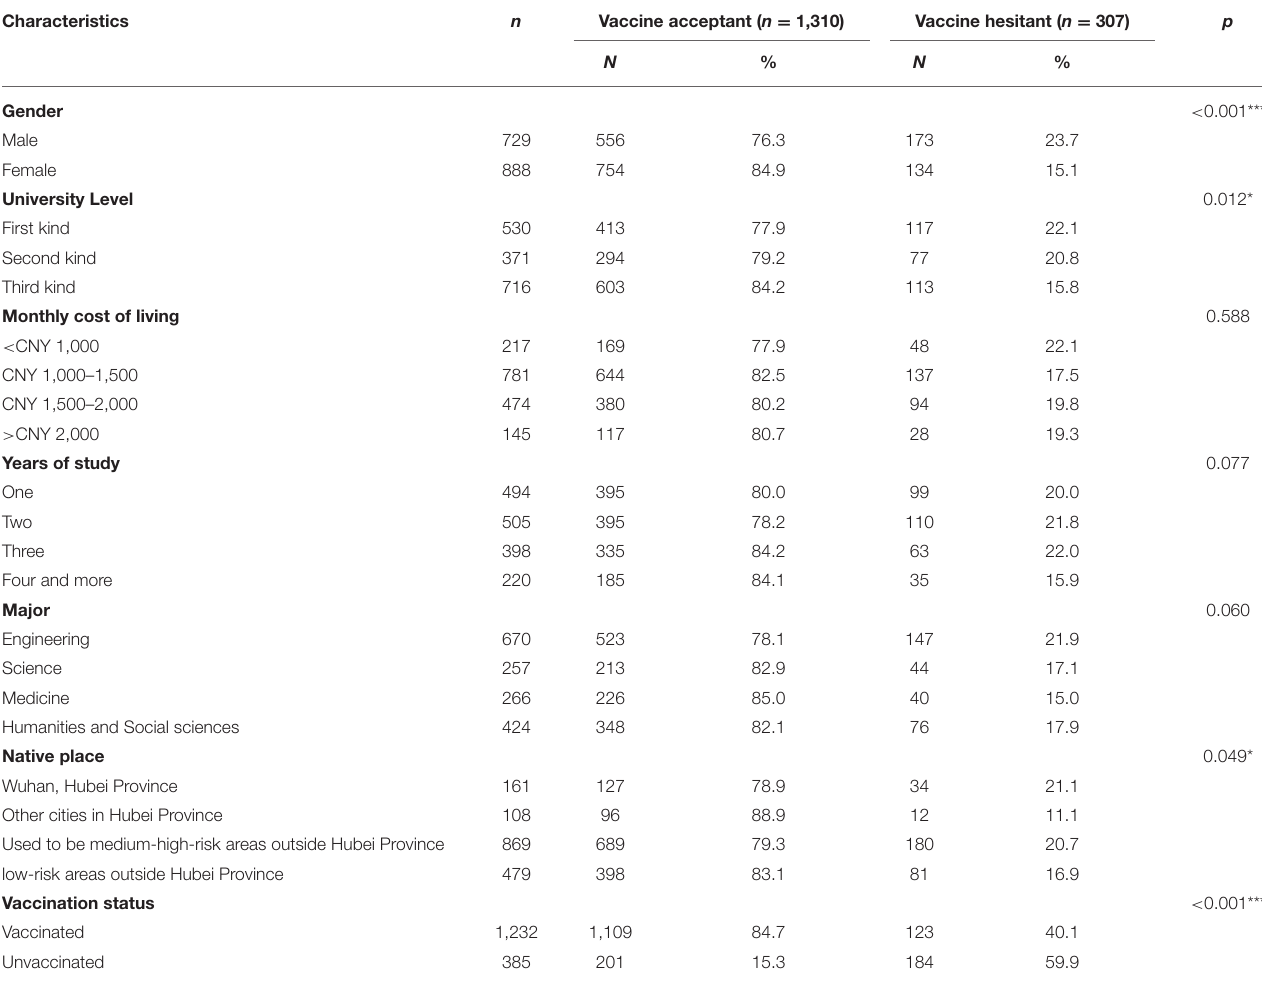
TABLE 1 | Characteristics and vaccination status of participants ( n = 1,617).